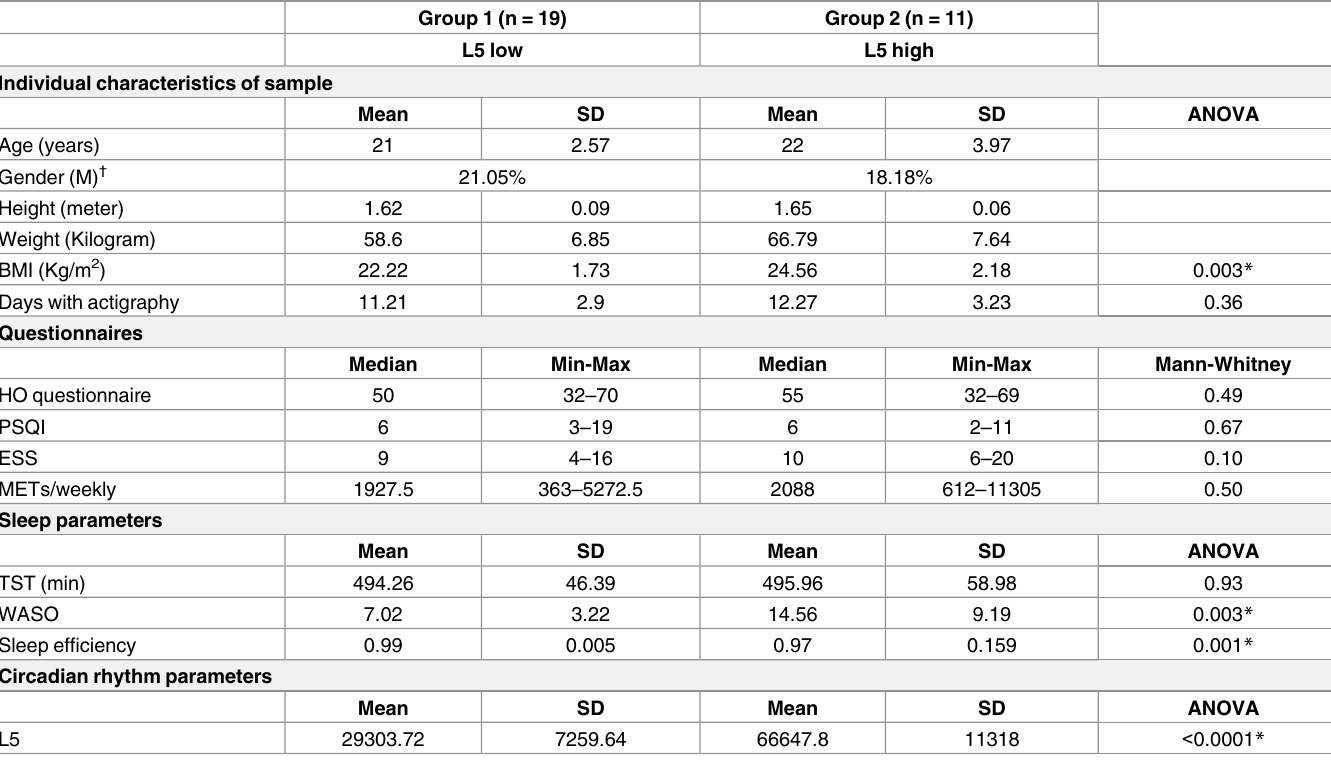
Table 1. Physical and sleep characteristics of the